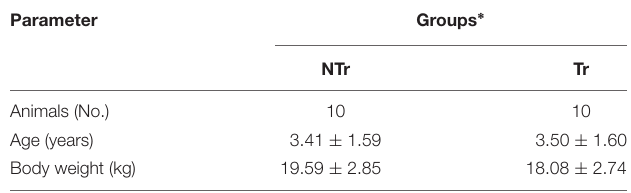
TABLE 1 | Characteristics of the experimental groups (mean ±